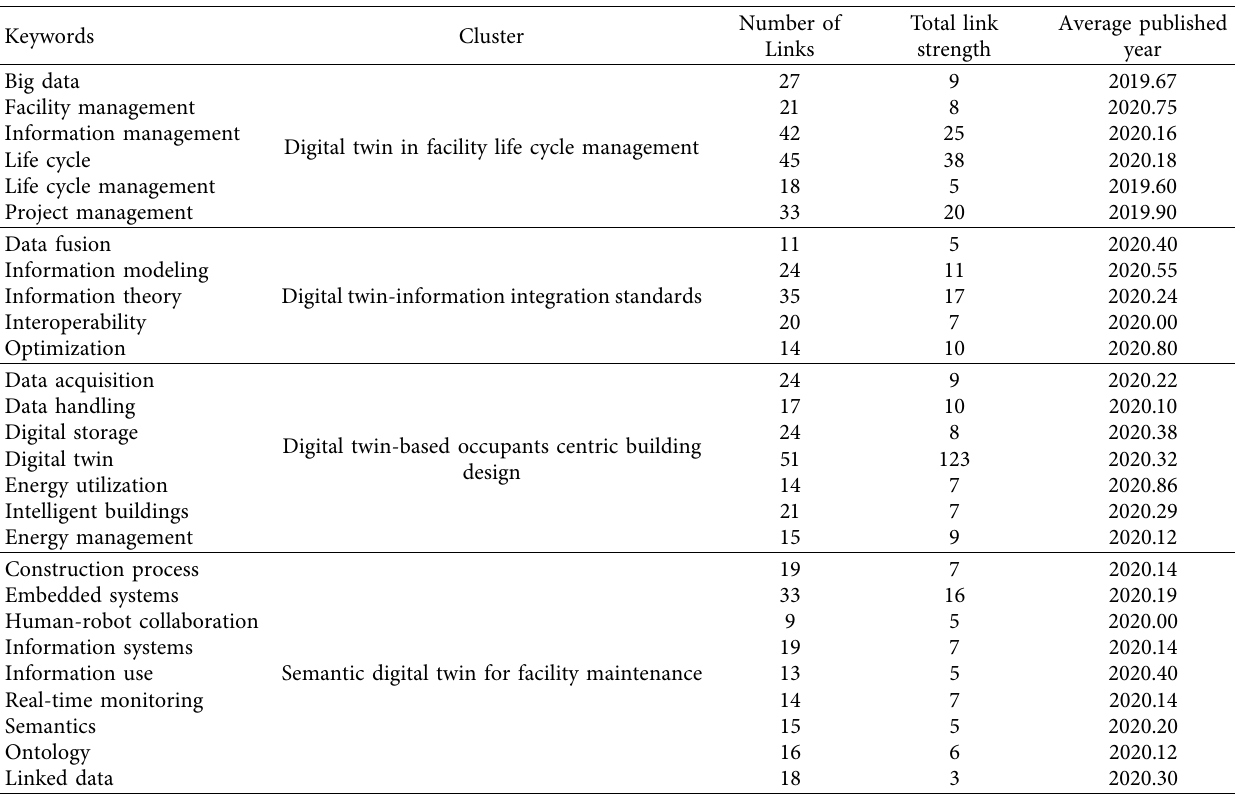
Figure 5: Network representation of keyword co-occurrence extracted from Google Scholar of the Digital Twin research in the AEC-FM industry from 2016 to 2022. Table 1: A scientometric study of items related to Digital Twin research in the AEC-FM industry from 2016 to